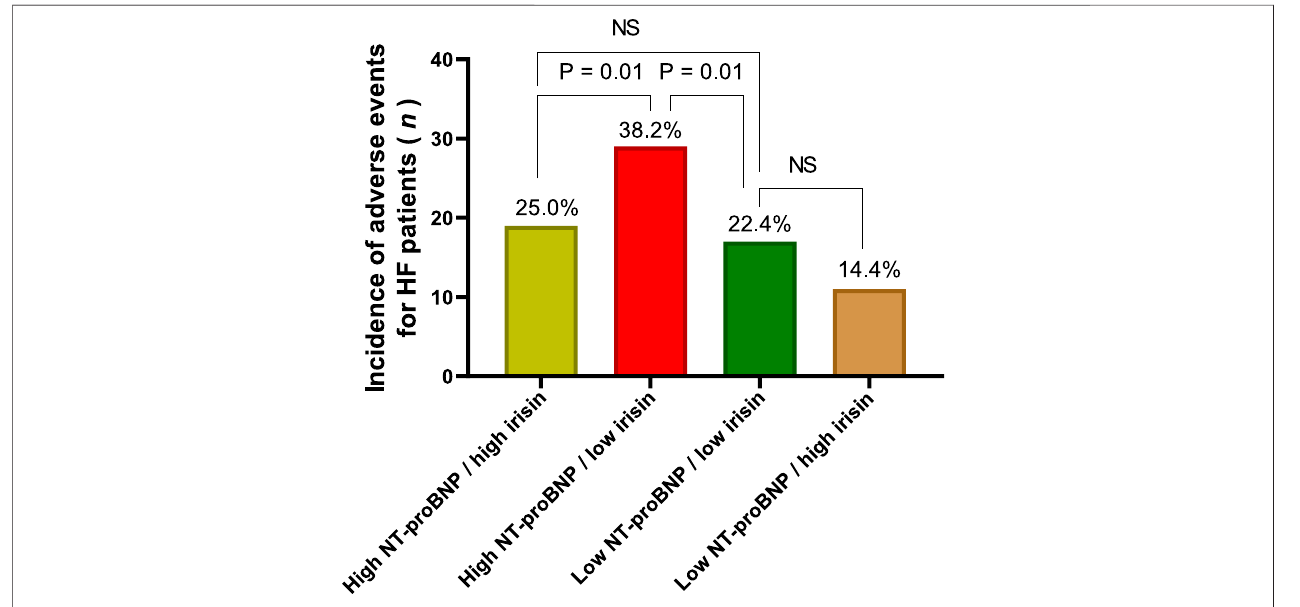
FIGURE3| TheincidenceofCVcompositeoutcomesdependingonthecompartmentofcirculatingbiomarkers.Note:HighNT-proBNPmeansNT-proBNPlevels > 2,250 pmol/ml,lowNT-proBNPmeansNT-proBNPlevels ≤ 2,250 pmol/ml;highirisinmeansirisinlevels ≥ 6.50 ng/ml;lowirisinmeansthelevelsofirisin < 6.50 ng/ml.